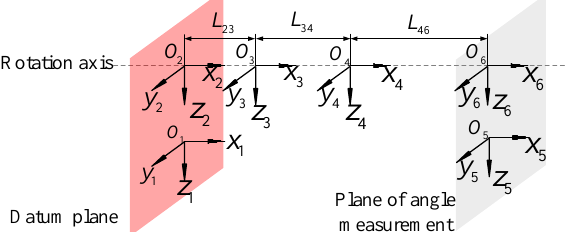
Figure 2. Schematic for corresponding coordinate system of the torsion angle measurement unit.